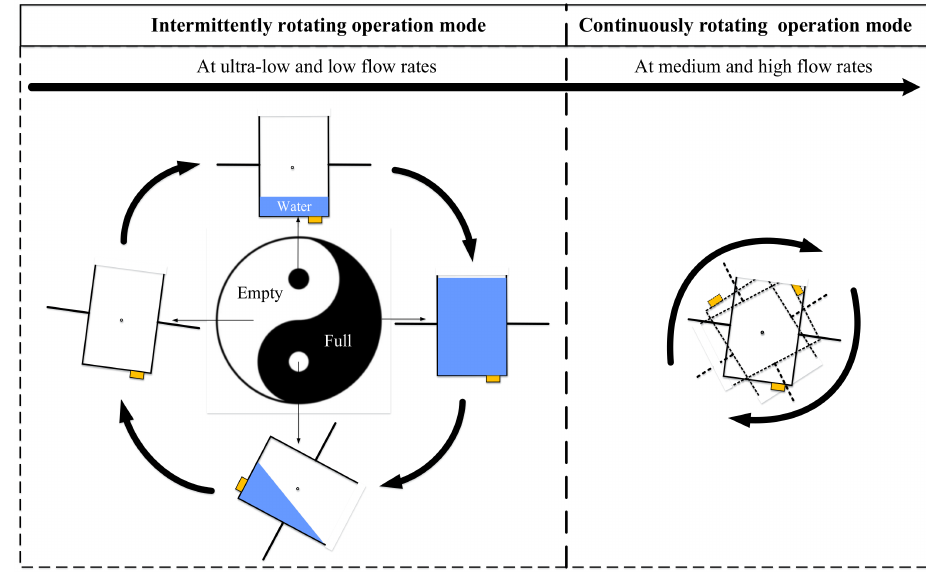
Figure 2. Working principle of the investigated structure.